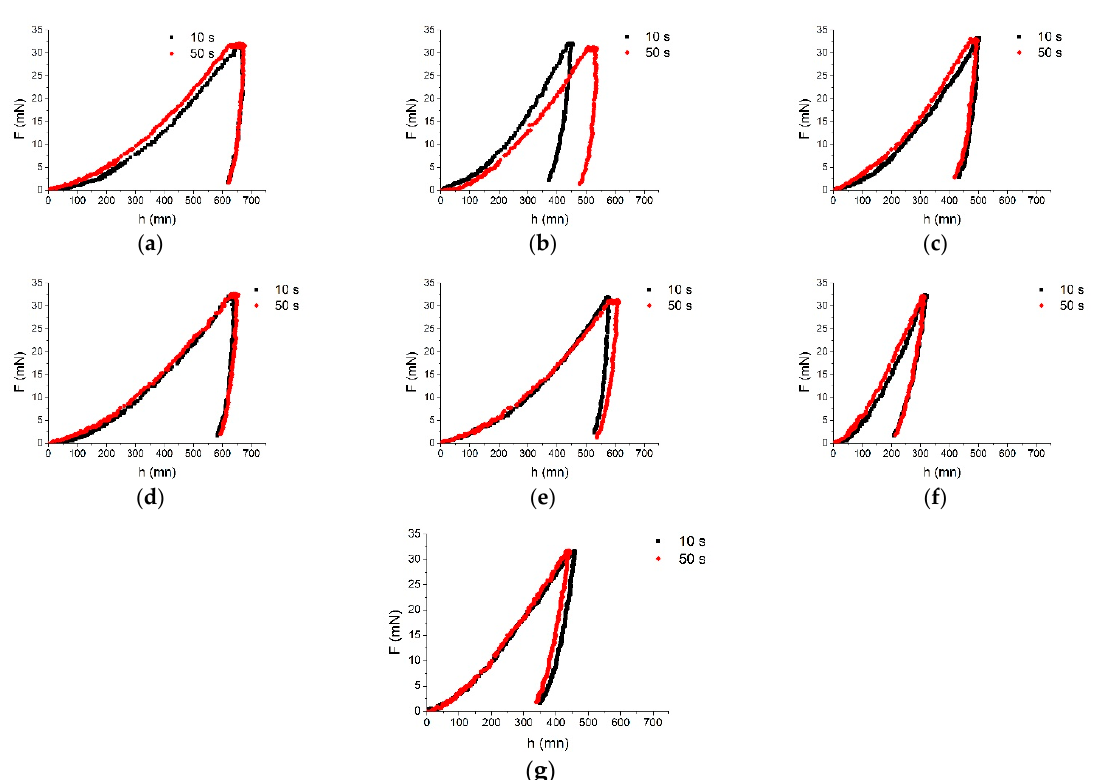
Figure 10. Typical load vs. displacement plots obtained for 10 s and 50 s holding time for: BM ( a ), BM-DAZ ( b ), DAZ-SSP ( c ), SSP ( d ), matrix in MZ ( e ), Ni-B (MZ) ( f ), Pd-Ni-Si (MZ) ( g ).